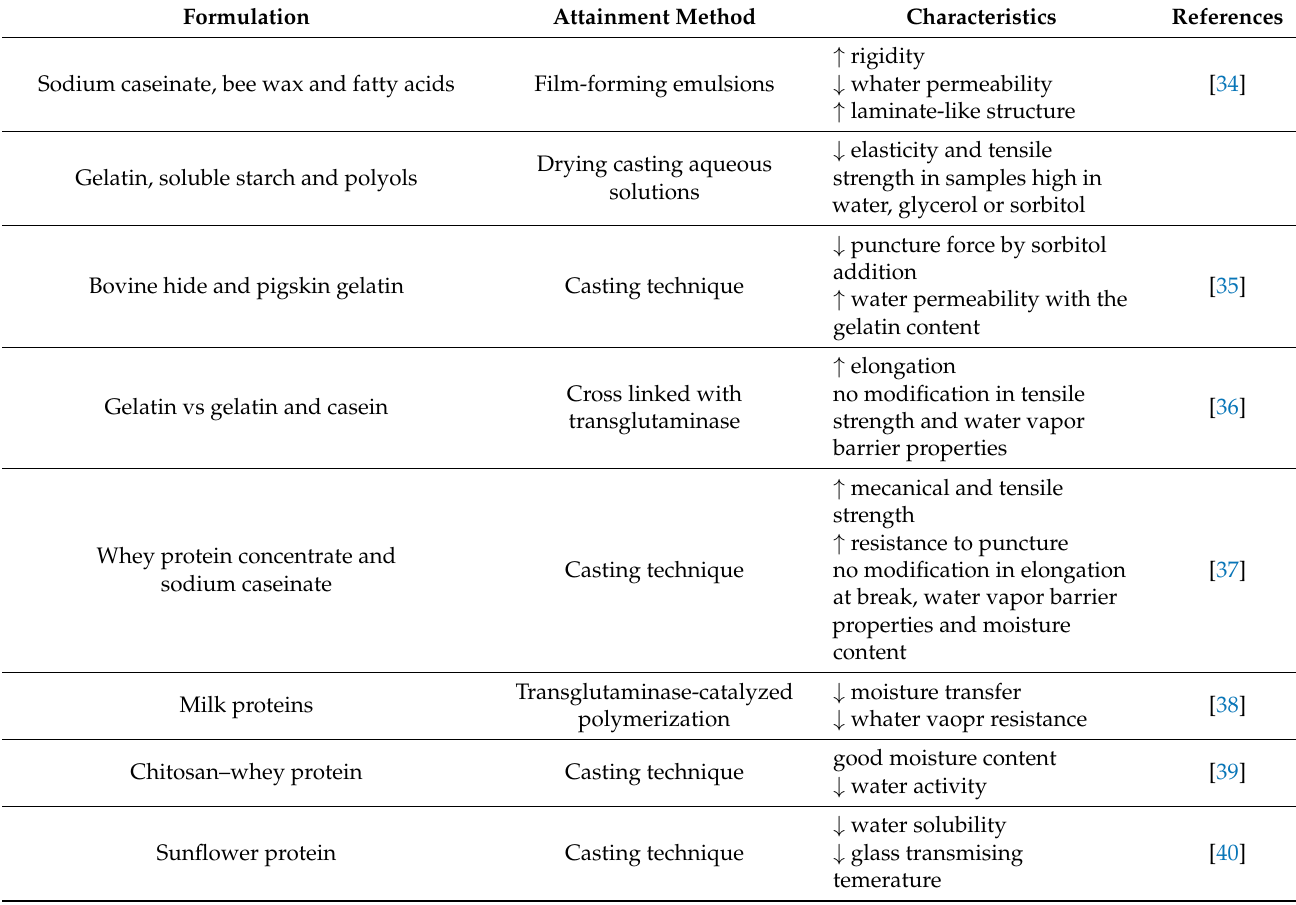
Table 1. Protein-based packages formulations and attainment